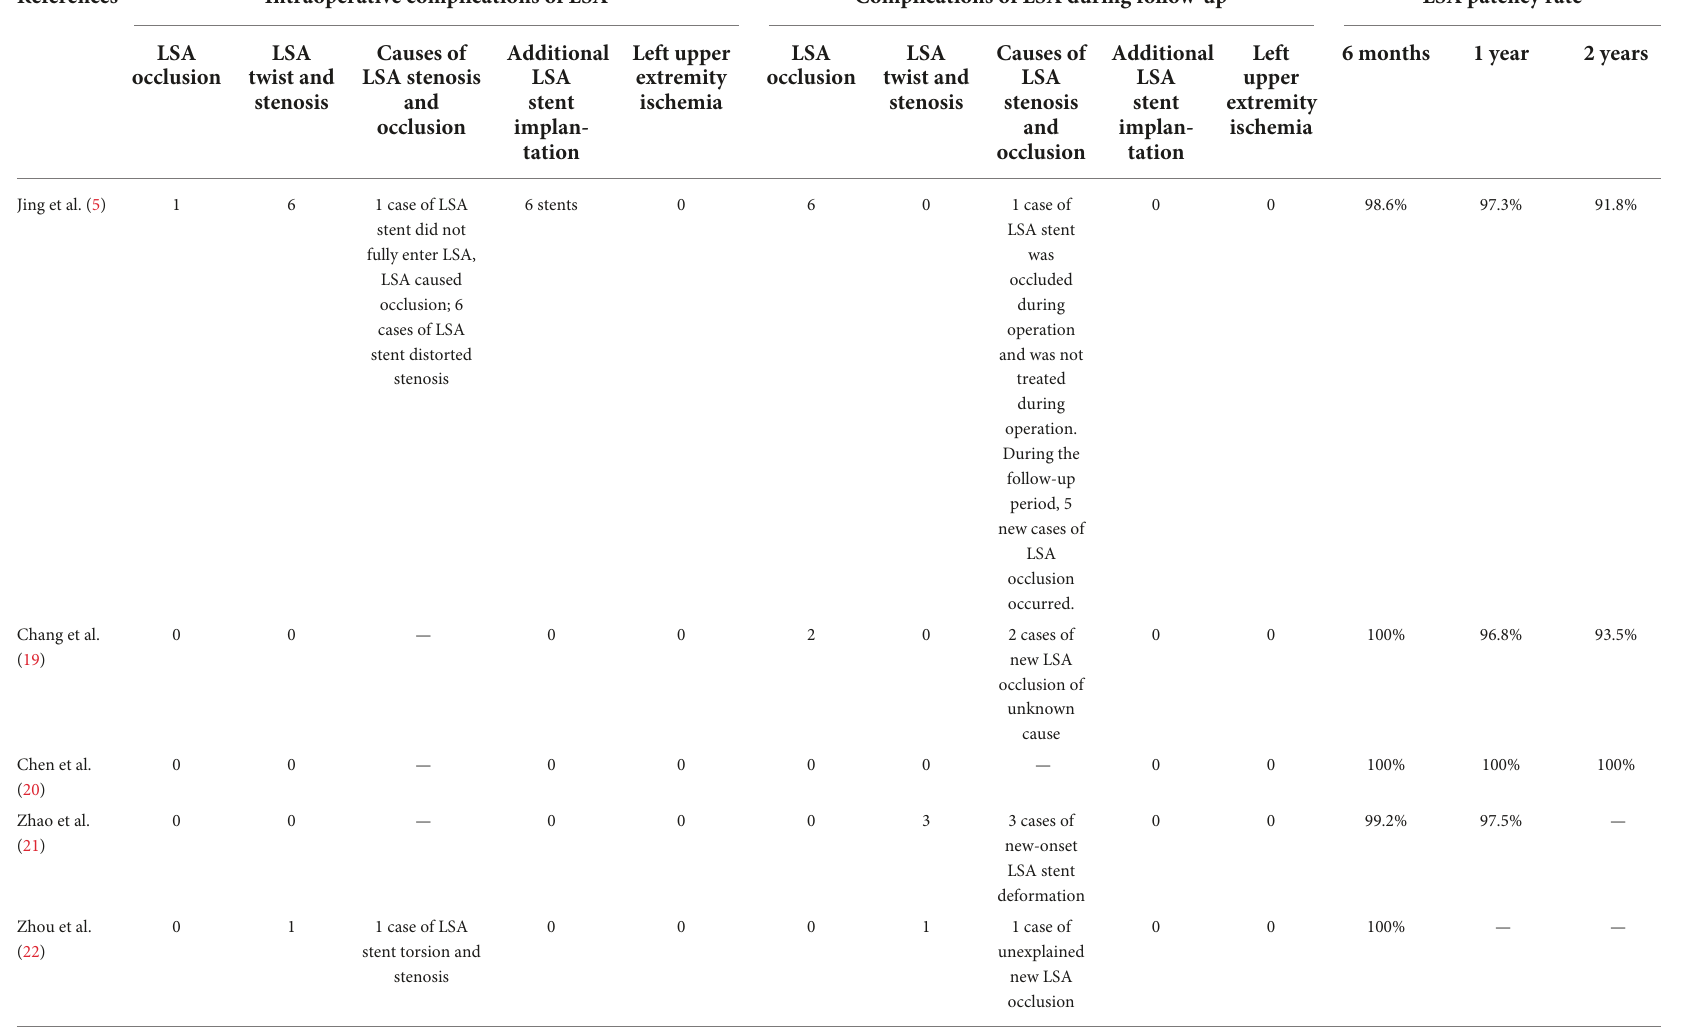
TABLE 3 Complications of left subclavian artery (LSA) Stents and left subclavian artery (LSA)